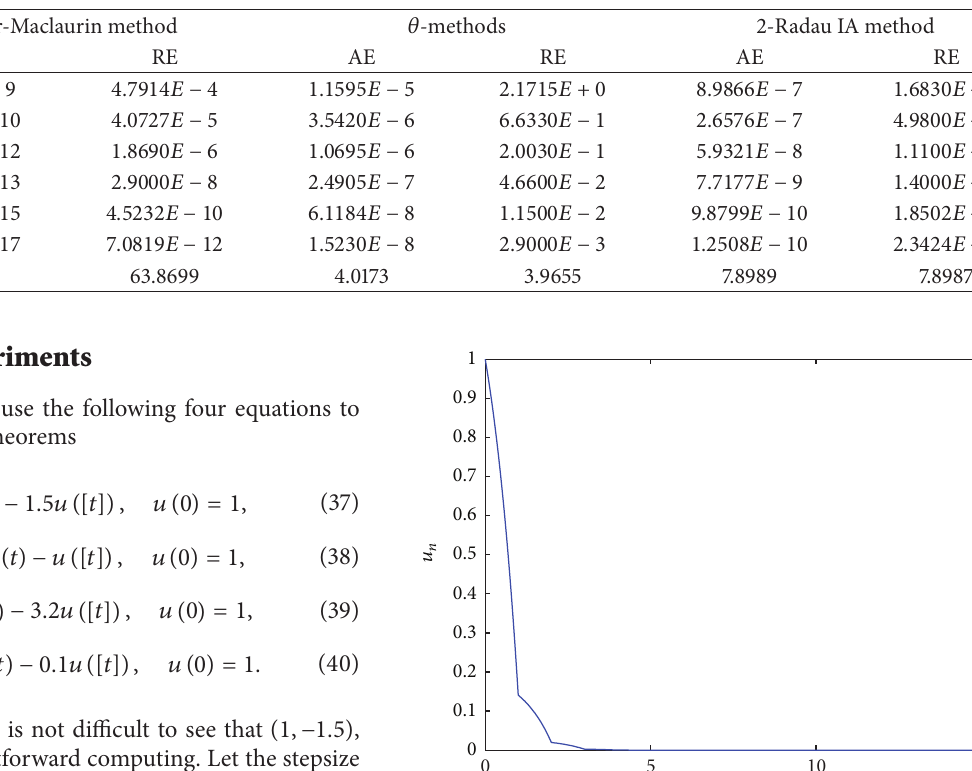
Table 2: Errors and ratio for (38).